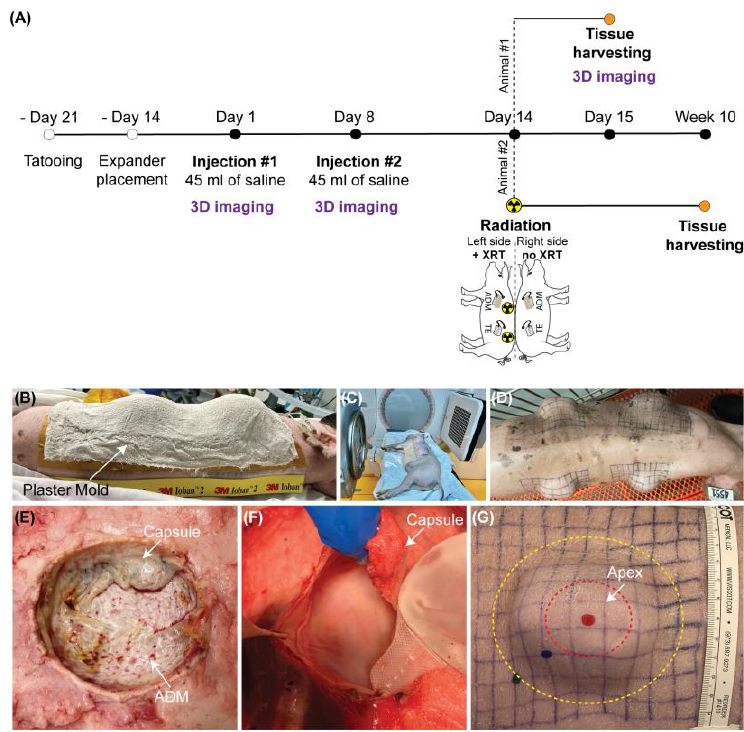
Figure 4. Overview of the study design. ( A ) Experimental timeline of the animal study. ( B – G ) Images presenting ( B ) utilization of a plaster mold of the intended radiation field, ( C ) pig radiation, ( D ) comparison between radiated and non-irradiated pig skin sites, ( E ) the underside of excised skin expanded with a tissue expander covered with acellular dermal matrix, ( F ) removal of the tissue expander encapsulated by connective tissue, ( G ) location of the apex of expanded skin, where skin biopsies were harvested from.